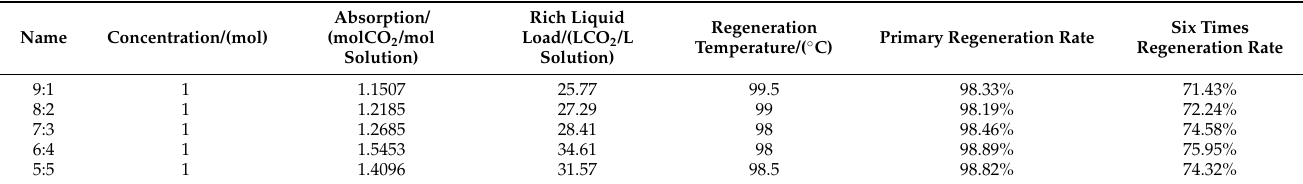
Table 9. Comparison summary of AEP-DPA composite system.